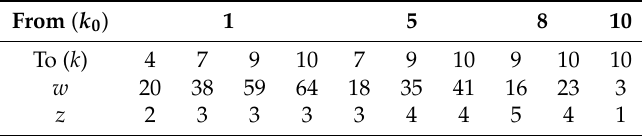
Table 4. Output data of Algorithm 3. The first header row ( k 0 ) represents the starting index of the sub-sequence. The second header row ( k ) represents the end index of the sub-sequence. Each column provides values of the minimum bit-length for the sub-sequence ( w ) and the corresponding value of the Rice parameter ( z ).